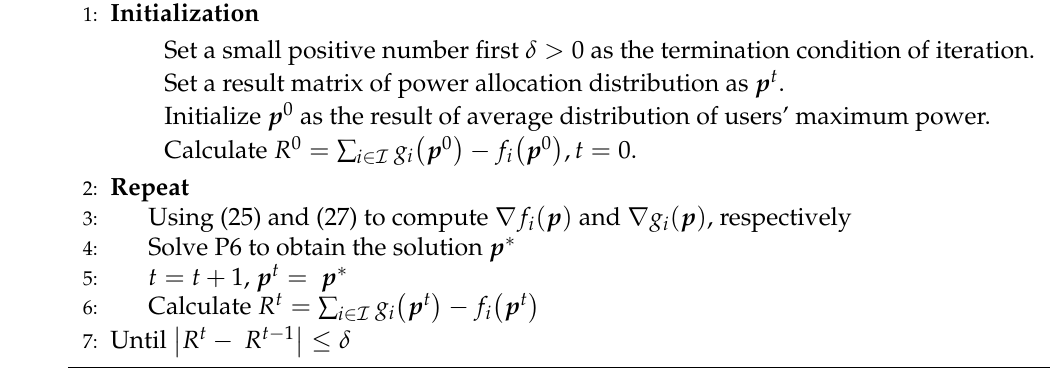
Algorithm 2 Power allocation algorithm (PA).